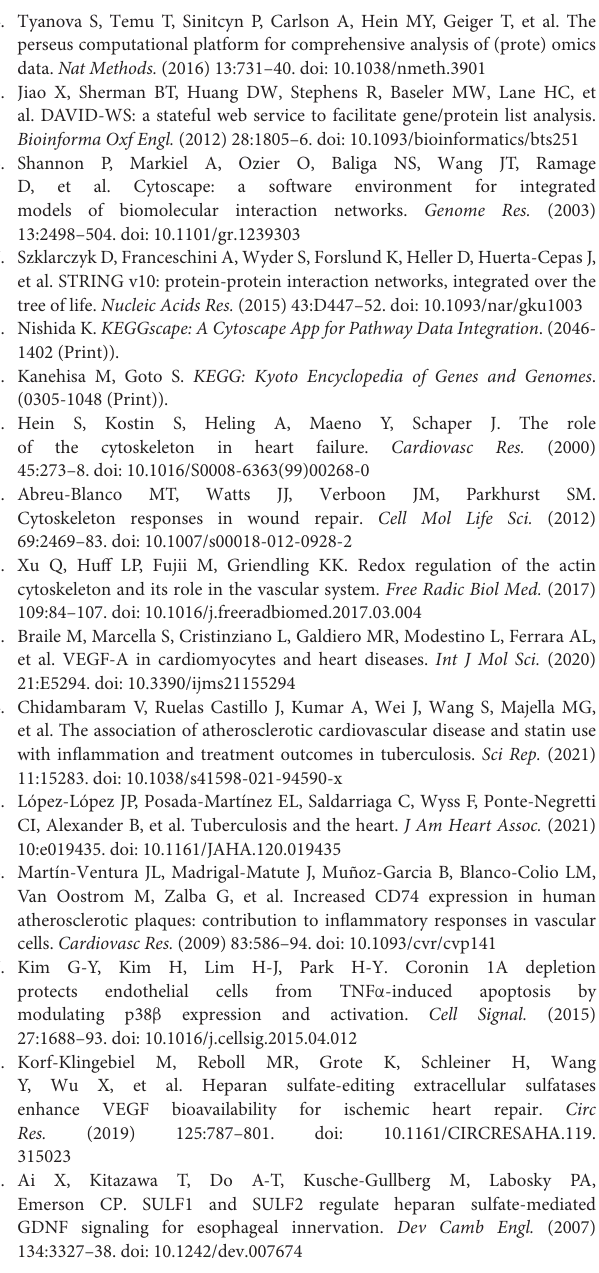
Supplementary Figure 1 | Overall experimental scheme of quantitative proteomic analysis. Supplementary Figure 2 | Label-free analysis strategy of the harvested tissues. Supplementary Figure 3 | (A) Coefficient variance (CV) distribution after width adjustment normalization of protein abundance from each sample. (B) Dynamic